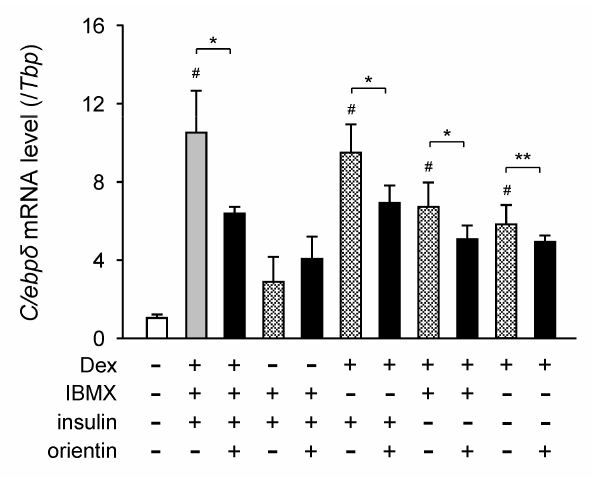
Figure 5. Reduction of dexamethasone (Dex)-mediated enhancement of C/ebp δ expression by orientin. 3T3-L1 cells were differentiated into adipocytes for 6 h in medium with (+) or without ( − ) 1 µ M Dex, 0.5 mM IBMX, 10 µ g/mL insulin, and/or 50 µ M orientin. Data are shown as the means ± S.D. from three experiments. * p < 0.01 and ** p < 0.05, as shown by the brackets. # p < 0.01, as compared with the vehicle-treated cells (white